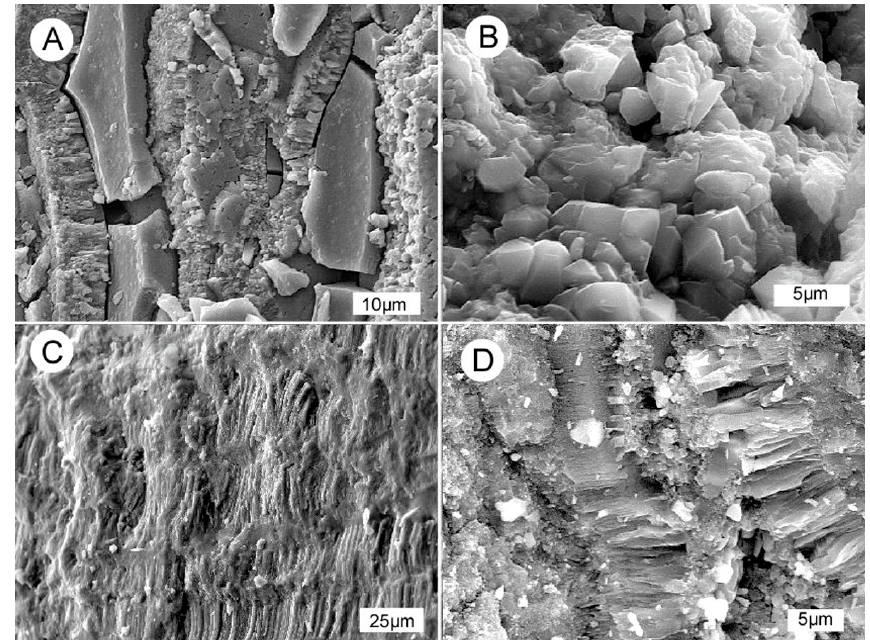
Figure 19. Microscrystalline quartz and fibrous chalcedony is present in some specimens, as indicated by SEM images. ( A ) Specimen T-16 (trunk 8) consists of fractured opal surrounded by microcrystalline quartz. This mixed composition is consistent with the intermediate opal / quartz density of 2.35 g / cm 3 . ( B ) Specimen 9 (trunk 5). Subhedral quartz crystals developed on fracture surface in opalized wood, explaining the intermediate opal / quartz density of 2.30 g / cm 3 . ( C ) Specimen T-12 (trunk 7). Chalcedony zones in quartz-mineralized wood (density 2.58 g / cm 3 ). ( D ) Specimen T-6 (trunk 4). High-magnification view of chalcedony in wood having an intermediate opal / quartz density of 2.43 g / cm 3